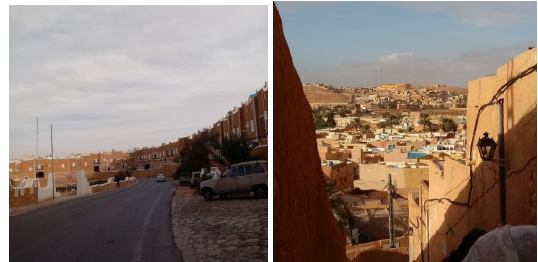
Figure 3: General view at Tafilelt at left and Beni Isguen at right (Author, 2017). The table 1 attempts to compare